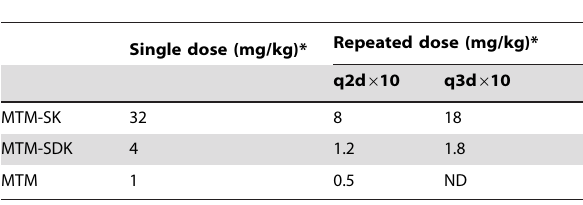
Table 1. Maximum tolerated doses of MTM compounds.